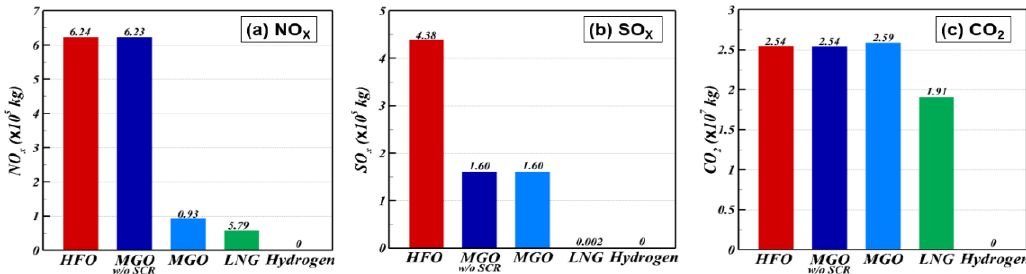
Figure 16. Comparison of ( a ) NOx, ( b ) SOx, and ( c ) CO 2 emissions in the tank-to-wake phase.